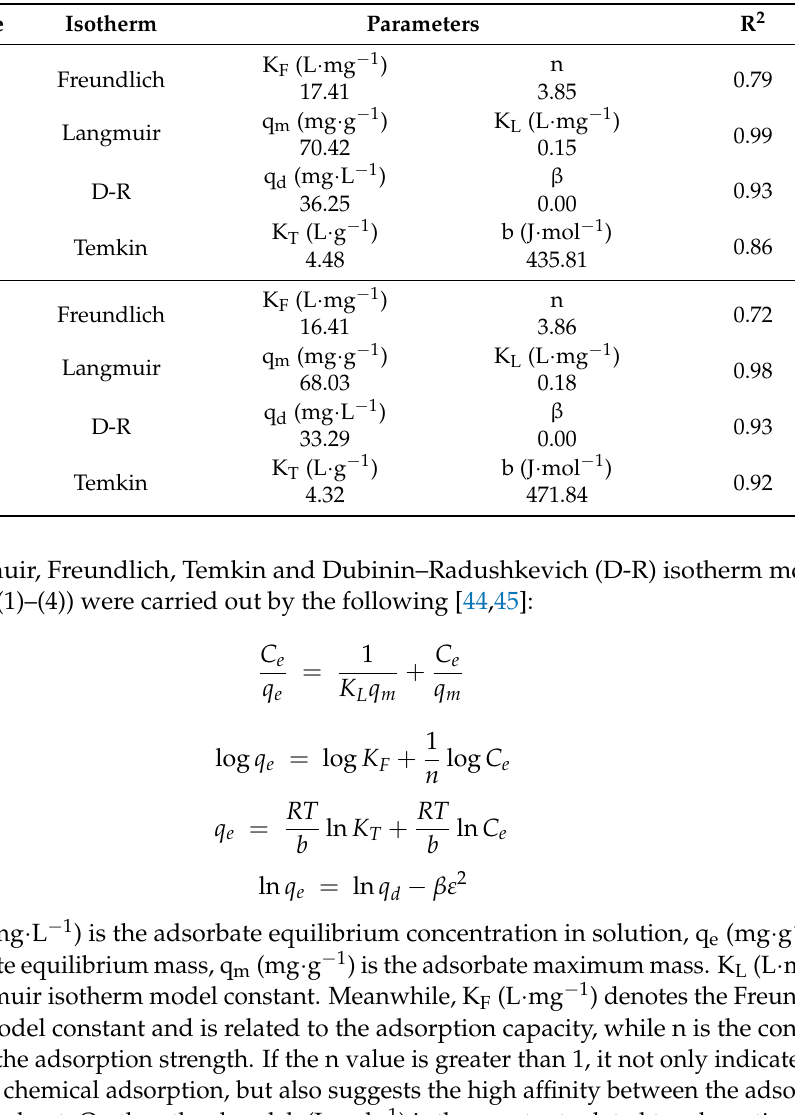
Table 1. The adsorption isotherms parameters for Cr(VI) and Cu(II) adsorption onto